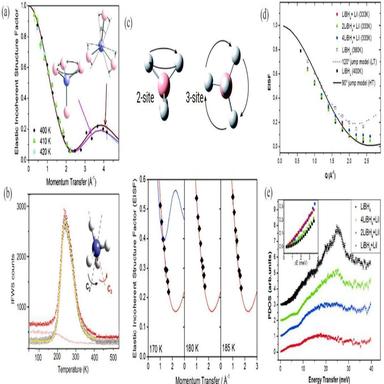
(a) QENS measurement-derived EISF for LiBH4 (HT phase) at 400, 410 and 420 K, respectively. Calculated curves for various reorientation models are presented for comparison. Inset: view along the c-axis depicting the partial delocalization model of the trigonal H atoms subtending an angle θ; (b) IFWS (inelastic scattering with fixed window scans) of LiBH4 (LT phase) (red dots, upper curve) measured at 2 μeV energy offset. The yellow continuous line is the fit and achieved by treating the pre-